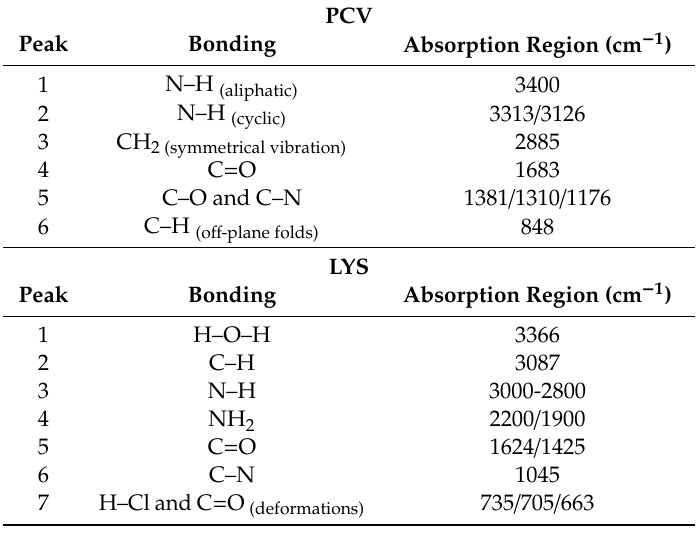
Table 1. Position and assignment of PCV and LYS FTIR bands.